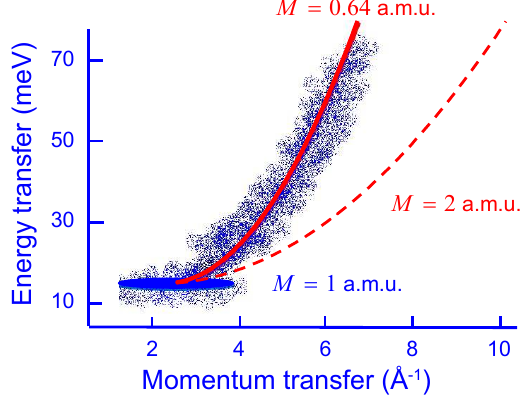
Figure 4: Schematic representation of incoherent inelastic neutron scattering results from H 2 in carbon nanotubes, with incident neutron energy E 0 = 90 meV [56, Fig. 1]. The transla- tion motion of the recoiling H 2 molecules causes the observed continuum of intensity, usually called roto-recoil (white-blue ribbon), starting at the well visible first rotational excitation of H 2 being centered at E ≈ 14 . 7 meV and K ≈ 2 . 7 Å − 1 (blue ellipsoid). The K − E position of the latter is in agreement with conventional theory. In contrast, a detailed fit (red parabola; full line) to the roto-recoil data reveals a strong reduction of the e ff ective mass of recoiling H 2 , which appears to be only 0.64 a.m.u. The red broken line (on the right) represents the conventional-theoretical parabola with e ff ective mass 2